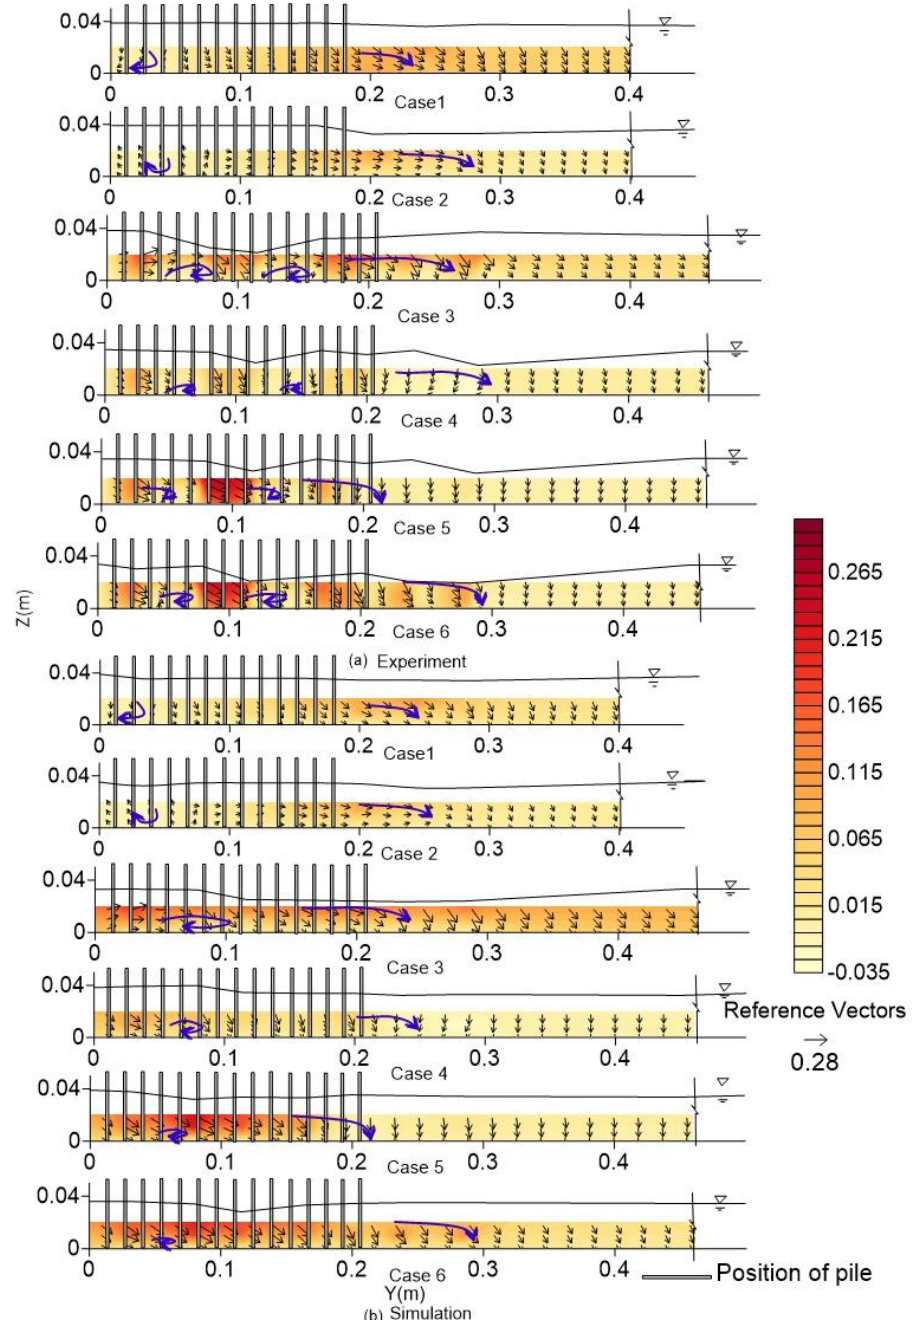
(cid:16) v (cid:17) w , 0.02 m upstream of the third spur dike. U U (cid:16) v (cid:17) U